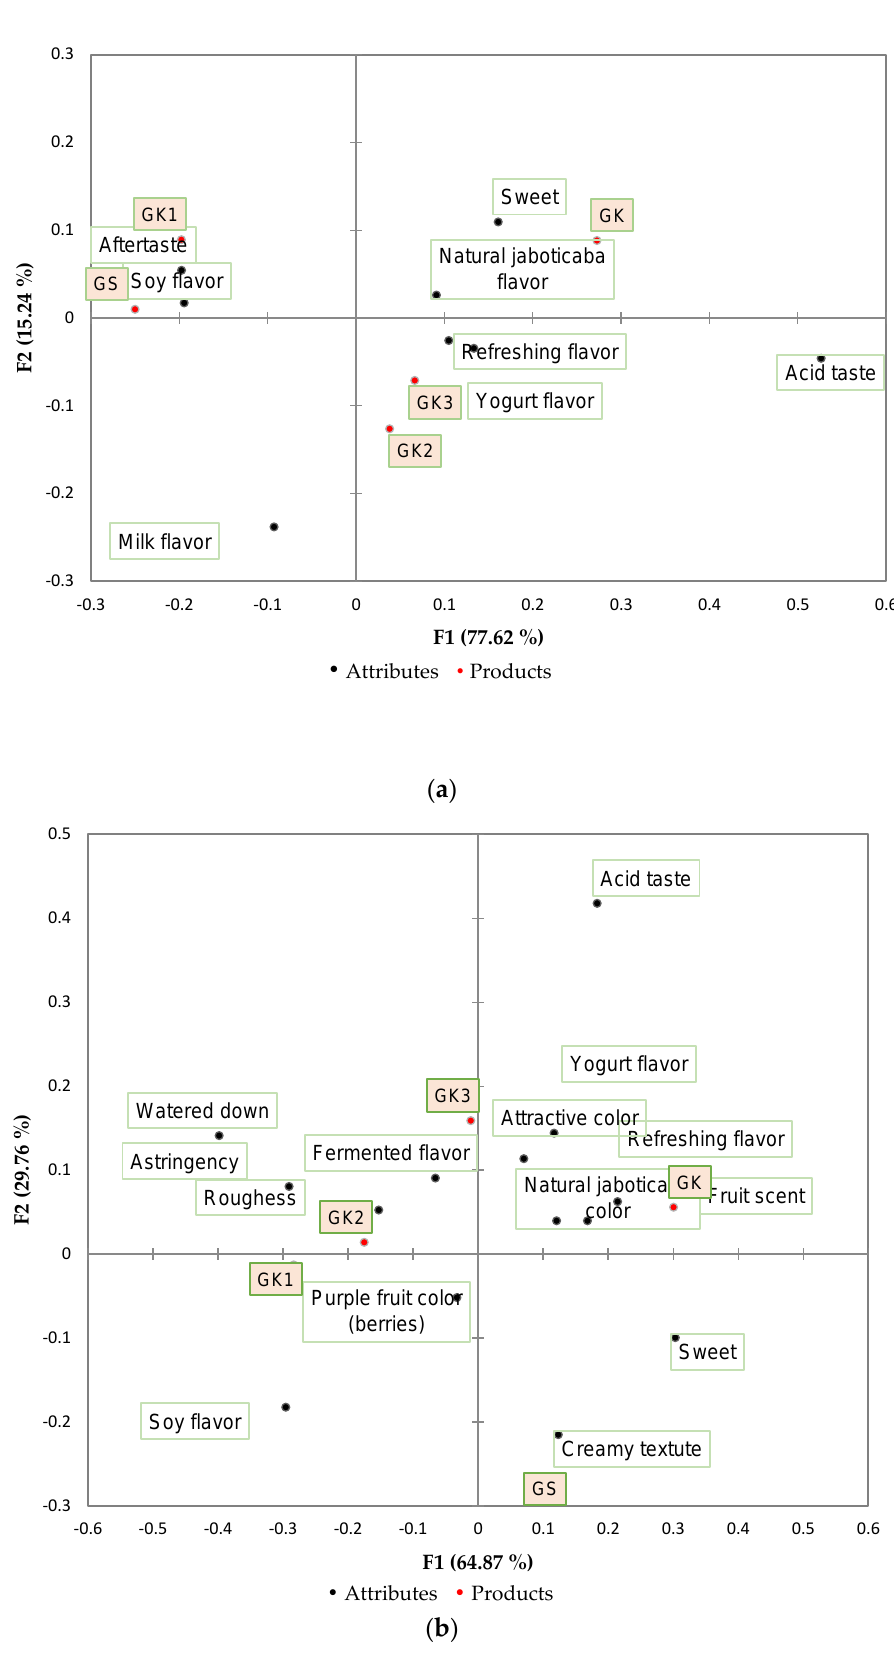
Figure 1. Correspondence analysis of the sensory descriptors in the CATA analysis for the initial time (T0) ( a ) and final time (T90) ( b ).